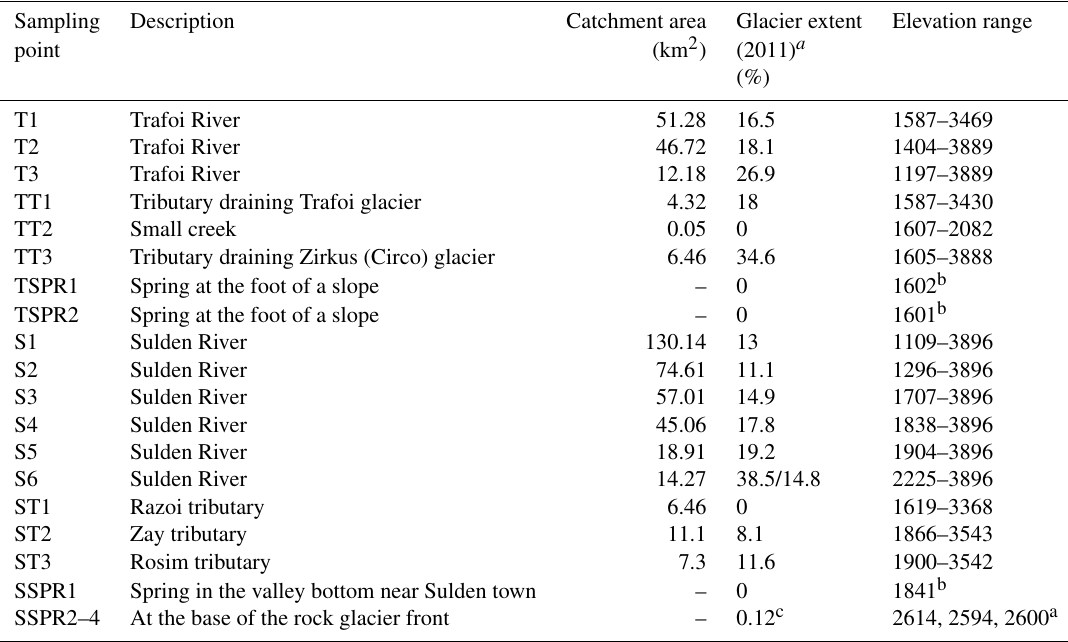
Table 2. Topographical characteristics of sub-catchments defined by sampling points.